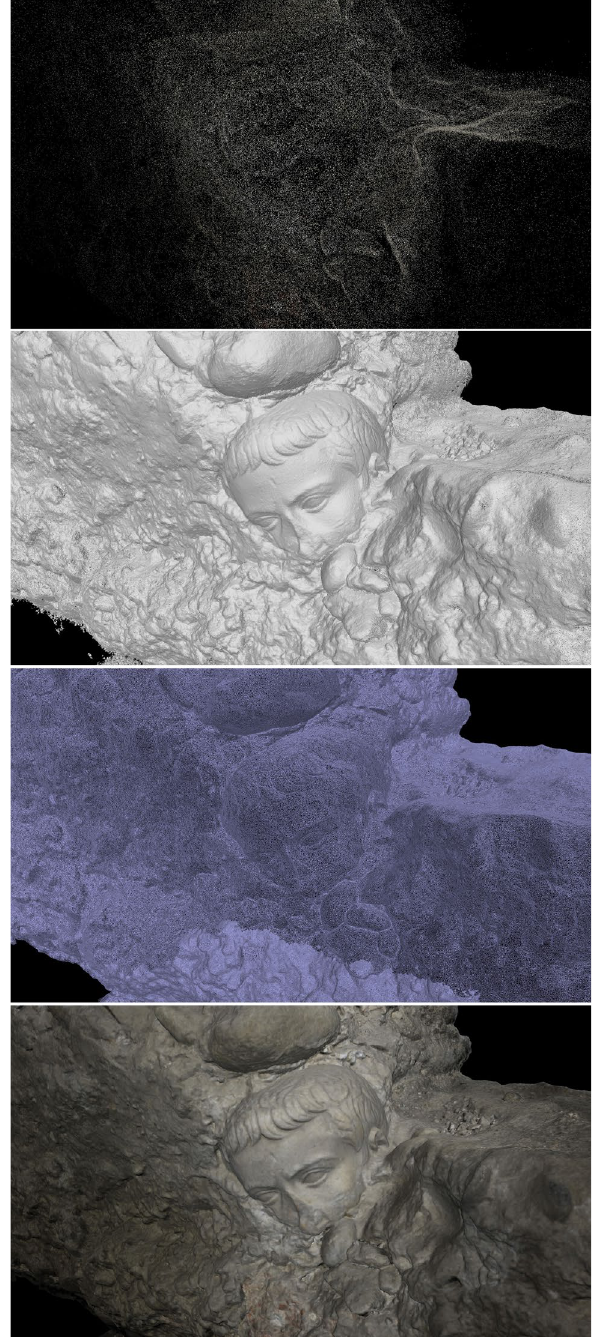
Figure 10. Sequence of the different processing steps for the realization of the high-resolution three-dimensional model of the “Testa di Tiberio” found in the archaeological site under the Church of Santa Maria alla Fonte in via Chiesa Rossa